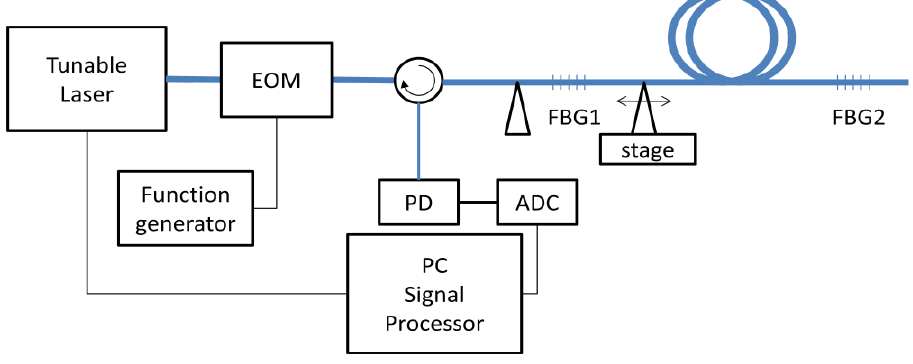
Figure 2. Experimental setup for investigation of shadowing effect of FBG sensor array in WDM/TDM multiplexing.